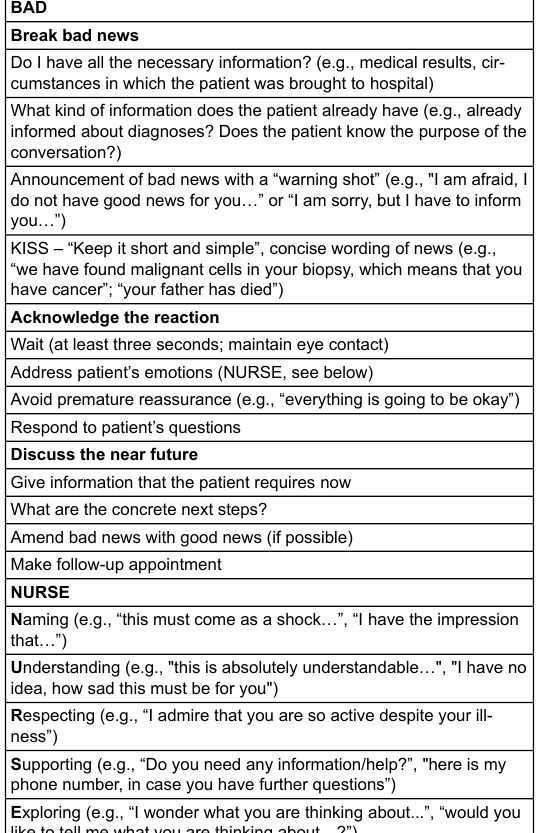
Table 1: BAD and NURSE communication strategies for the disclosure of bad news. BAD